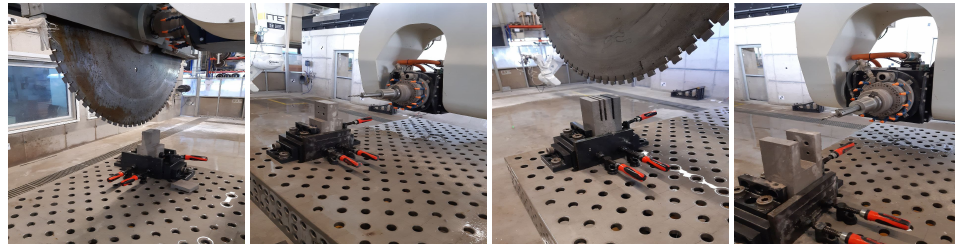
Figure 23. F8: milling process of both couples; left-pare: duration: 8 min, speed: 50%, Ra: 500 (rad/min); right-pare: duration: 15 min, speed: 50%, Ra: 500 (rad/min), (DBFL, ITE and TU-